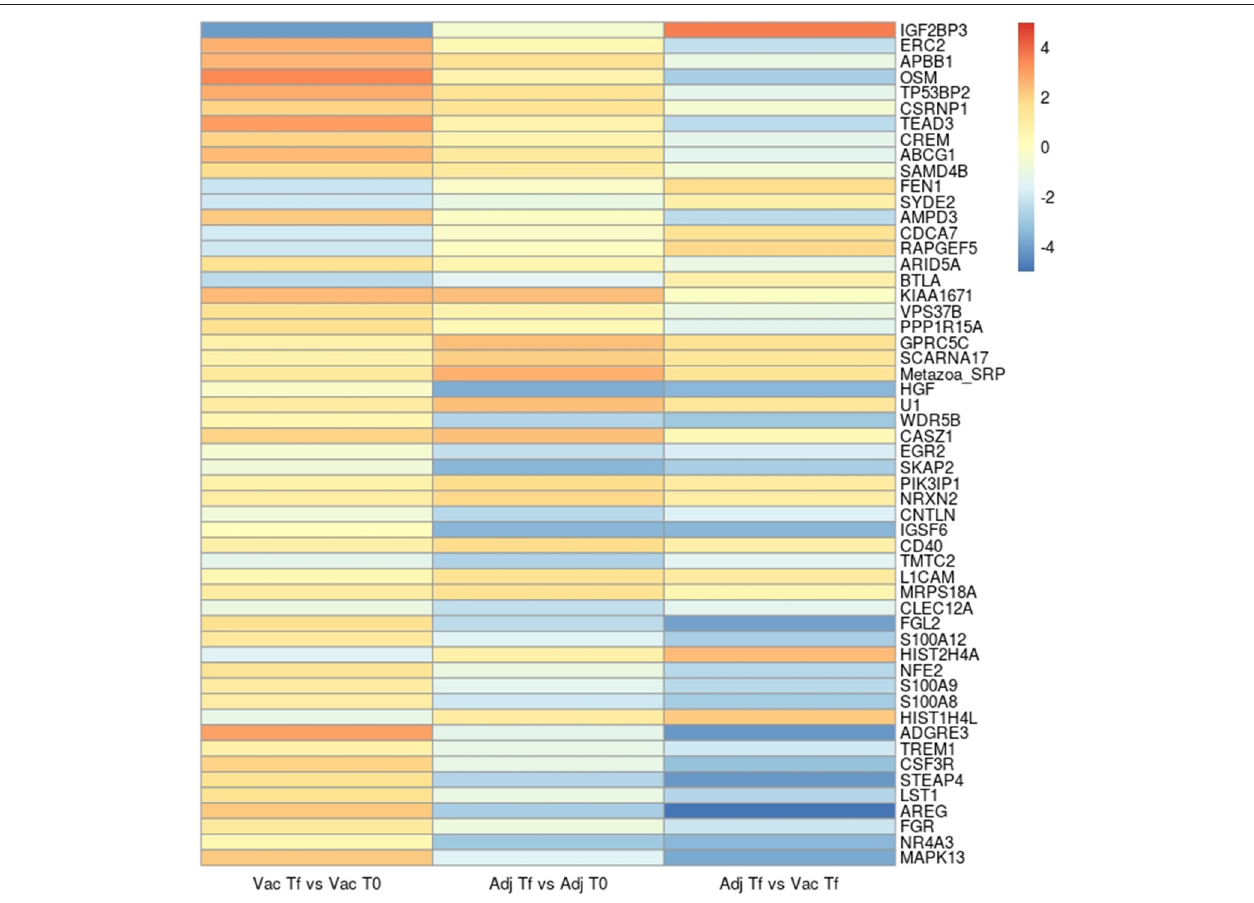
FIGURE 1 | Heatmap with the log2(Fold change) of the top 10 significant up- and down-regulated genes in the Vac Tf vs. Vac T0, Adj Tf vs. Adj T0, and Adj Tf vs. Vac Tf comparisons. The genes were selected from those found differentially expressed in 3 different programs: limma, edger, and DESeq2.